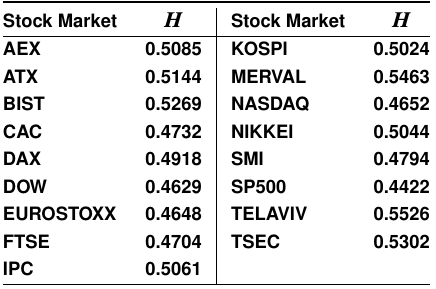
Table 1. The H values of each stock market. TELAVIV and SP500 have the strongest positive and negative autocorrelations, respectively. AEX, DAX, IPC, KOSPI, and NIKKEI are almost